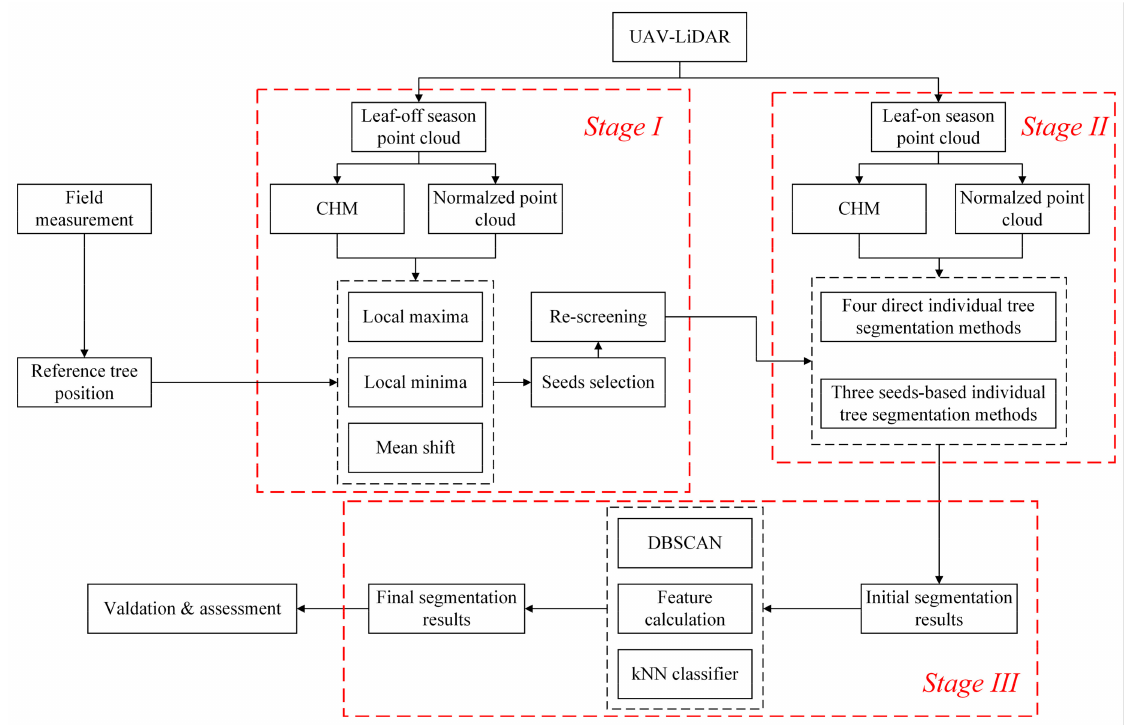
Figure 3. Methodology developed in this study. CHM: canopy height model; DBSCAN: density- based spatial clustering of applications with noise; kNN classifier: k-Nearest Neighbor classifier. Stage I: ITD and seed points detection under leaf-off conditions; Stage II: ITS in leaf-on conditions; Stage III: Refining processing to final segmentation